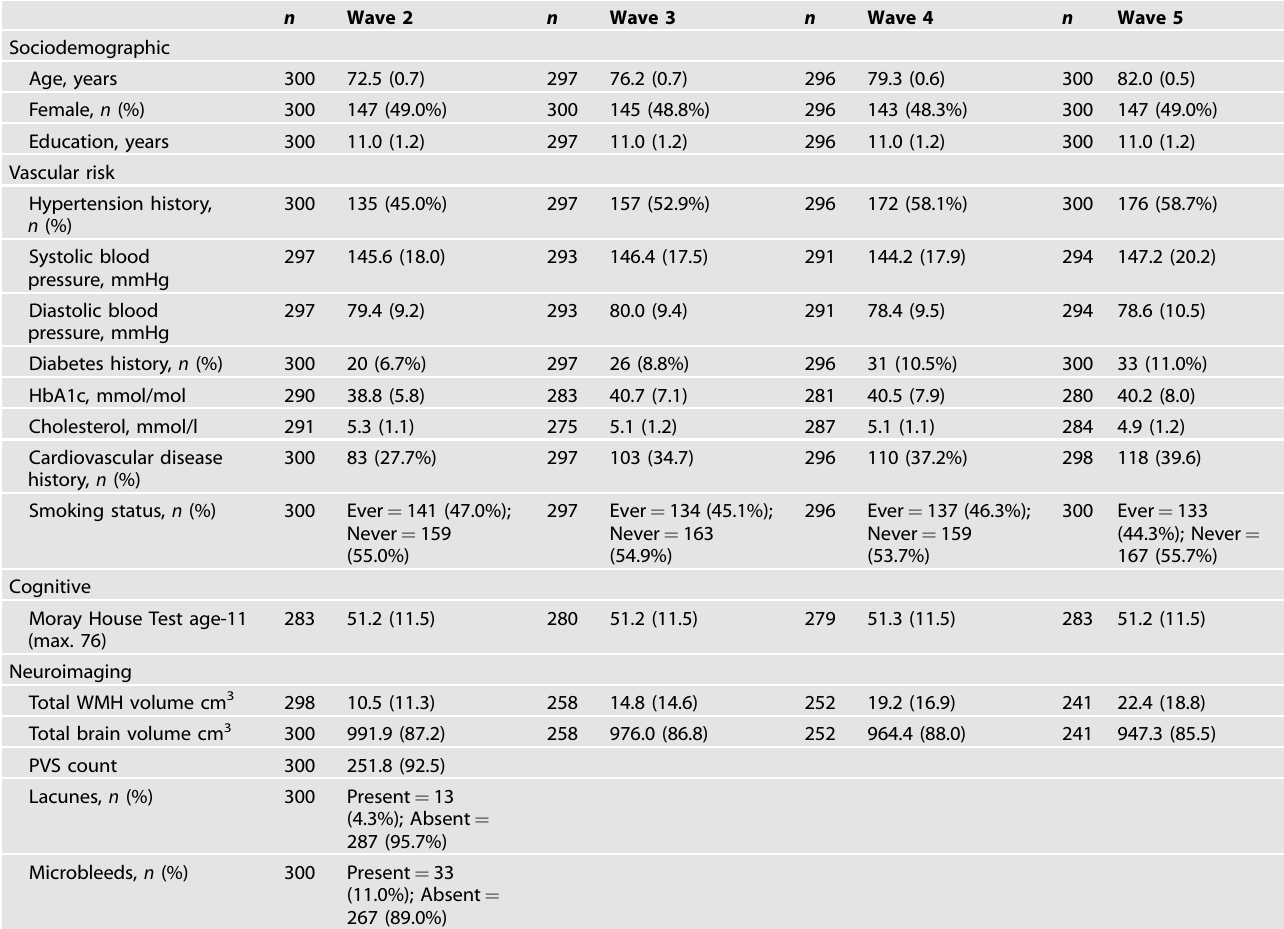
Table 1. Characteristics of study completers only, at each